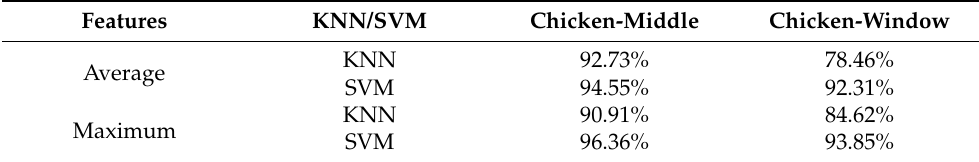
Table 4. The accuracy for odor classification in the same sampling location of piggery at different sampling times. Features